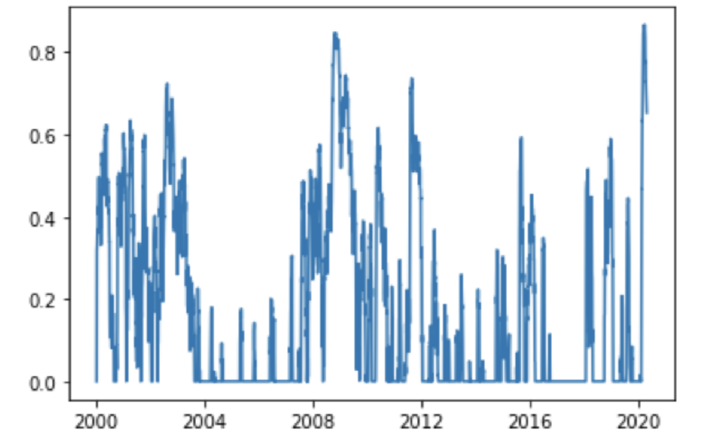
Figure 11. Exposure of the risk-free asset described by the weights α 0 (source: authors’ calculations).